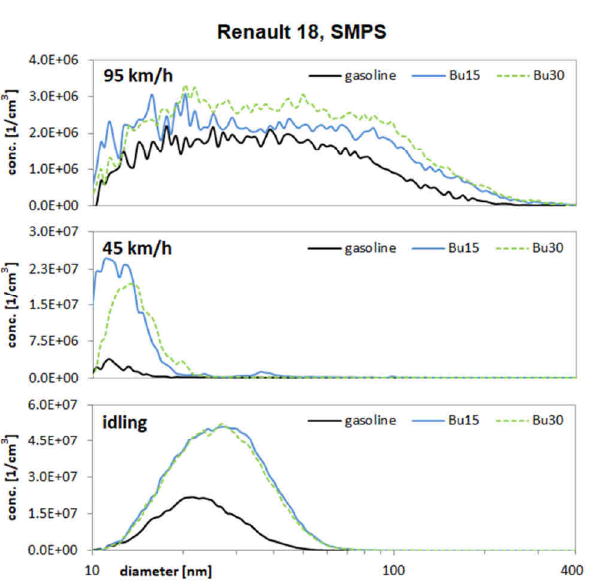
Fig. 12. Comparison of the Particle Size Distribution (PSD) during the driving cycle SSC with different